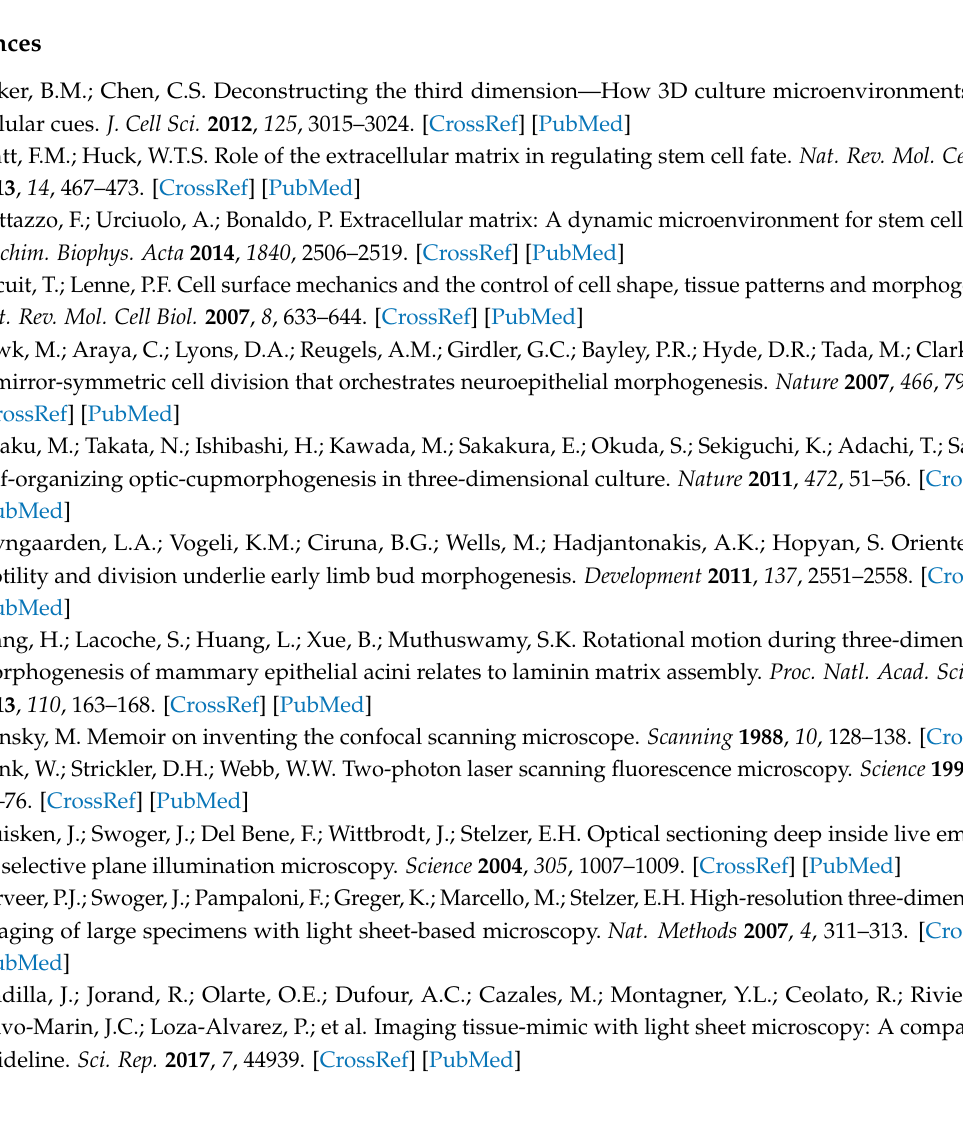
Figure A1. Image processing for synchronizing multiple datasets. ( A ) Slice images were linearly interpolated to match the resolution in the z-direction. ( B ) Overview image of spatial alignment using the SU-8 alignment mark. The most easily recognized vertex point from multiple directions was selected, and its ( x i , y i , z i ) position was determined. Images were aligned by setting this single point as a global reference point. ( C ) Scanning data from two opposite sides were averaged to reduce differences in signal intensity that depend on the distance from the objective lens.